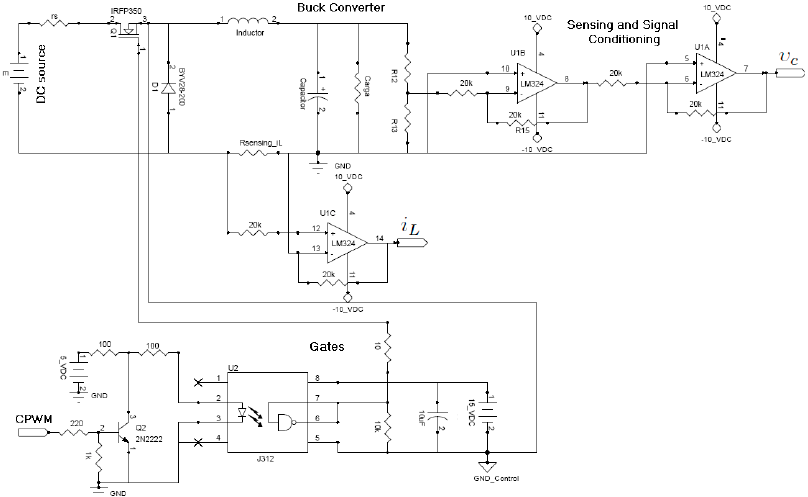
Figure 6. Hardware implemented for the analogic circuit.